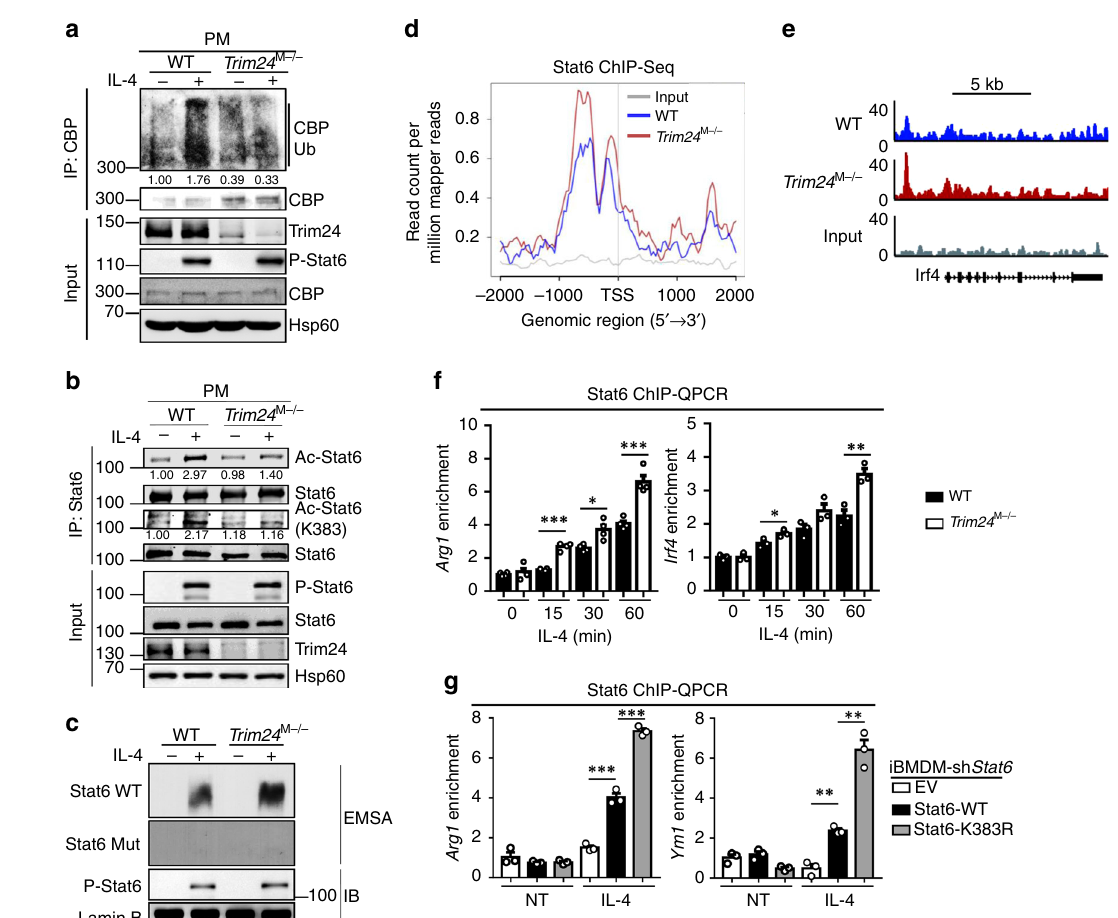
Fig. 5 Trim24 de fi ciency enhanced DNA-binding activity of Stat6 in M2 gene promoters. a Endogenous ubiquitination of CBP in WT and Trim24 -de fi cient macrophages that were unstimulated ( − ) or stimulated ( + ) with IL-4 for 30 min assessed by immunoblot analysis with anti-ubiquitin after immunoprecipitation with anti-CBP (top) and immunoblot analysis with input proteins and loading controls (below). b Immunoblot analysis of endogenous lysine acetylation of Stat6 in WT and Trim24 -de fi cient peritoneal macrophages (PMs) that were unstimulated ( − ) or stimulated ( + ) with IL-4 for 30 min assessed by immunoprecipitation (IP) with anti-Stat6 and immunoblotting with anti-Ac-Lys, anti-Ac-Stat6 (K383), and anti-Stat6. c Electrophoretic mobility shift assay (EMSA) of nuclear extracts from WT and Trim24 -de fi cient macrophages that were untreated ( − ) or stimulated ( + ) with IL-4 for 1 h assessed with 32 P-radiolabeled WT or mutant probes for Stat6. Immunoblotting of phosphorylated (P − ) Stat6 and Lamin B in the nuclear extract were applied for control. d Average Stat6 ChIP signals in the promoter regions of M2 cluster genes in WT and Trim24 -de fi cient macrophages stimulated with IL-4 for 1 h. e Snapshot of the Stat6 ChIP-Seq signals at the Irf4 gene loci in WT and Trim24 -de fi cient macrophages stimulated with IL-4 for 1 h. f , g ChIP – QPCR analysis of Stat6 binding to the promoters of Arg1 and Irf4 in WT and Trim24 -de fi cient macrophages that were left nontreated or stimulated with IL-4 for the indicated time points ( f ) or Stat6 binding to the promoters of Arg1 and Ym1 in Stat6- knockdown iBMDMs that were reconstituted with empty vector (EV), WT, or the K383R mutant Stat6 and then were left nontreated (NT) or stimulated with IL-4 for 1 h ( g ). Data with error bars are represented as mean ± SD. Each panel is a representative experiment of at least three independent biological replicates. ∗ p < 0.05, ∗∗ p < 0.01, ∗∗∗ p <